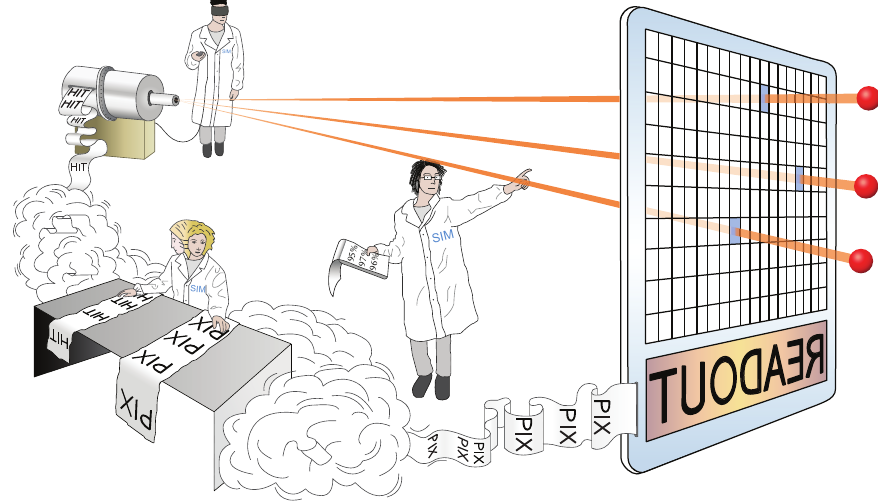
Figure 3: Hit identification concept.